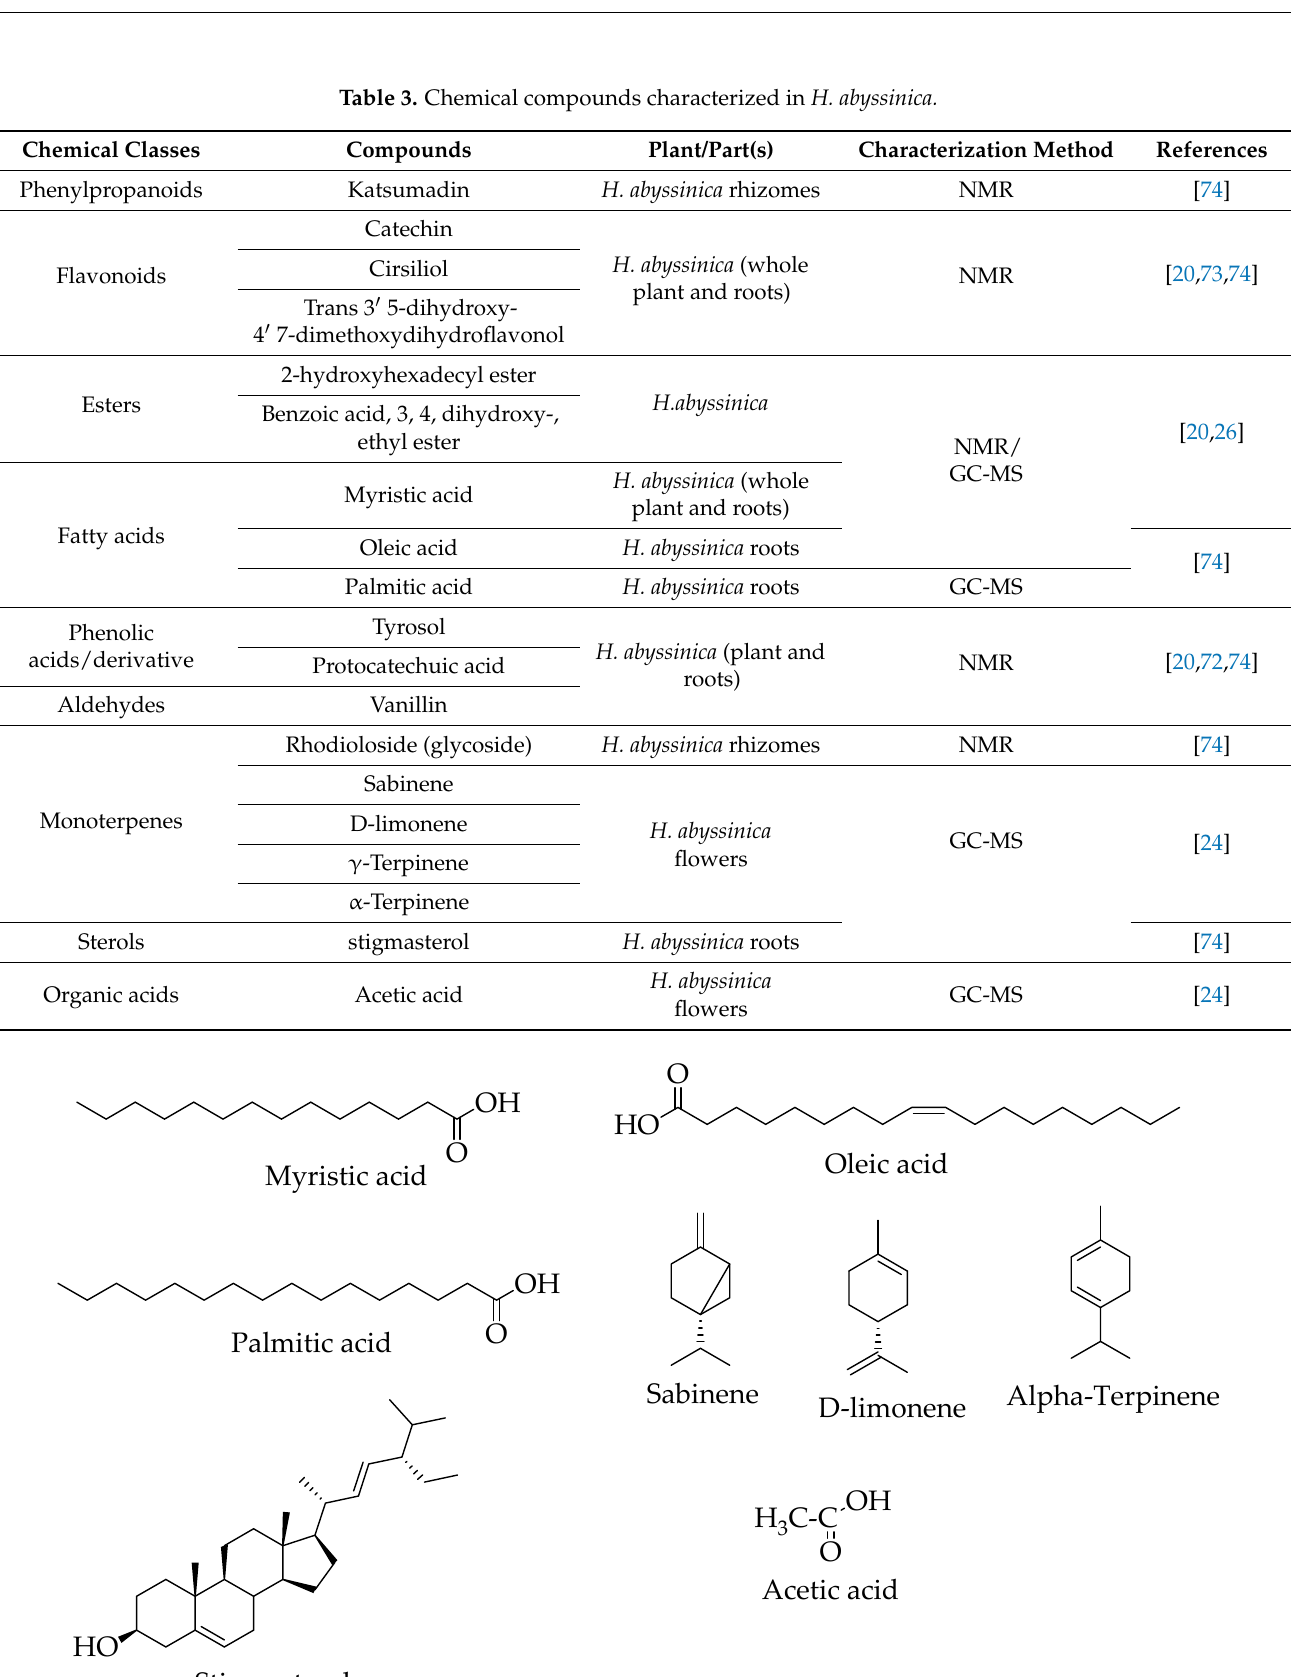
Figure 7. Chemical structures of isolated compounds from H. abyssinica.